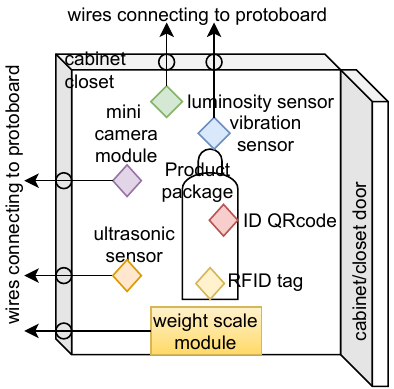
Figure 7. Simple schematic showing sensors and package inside a